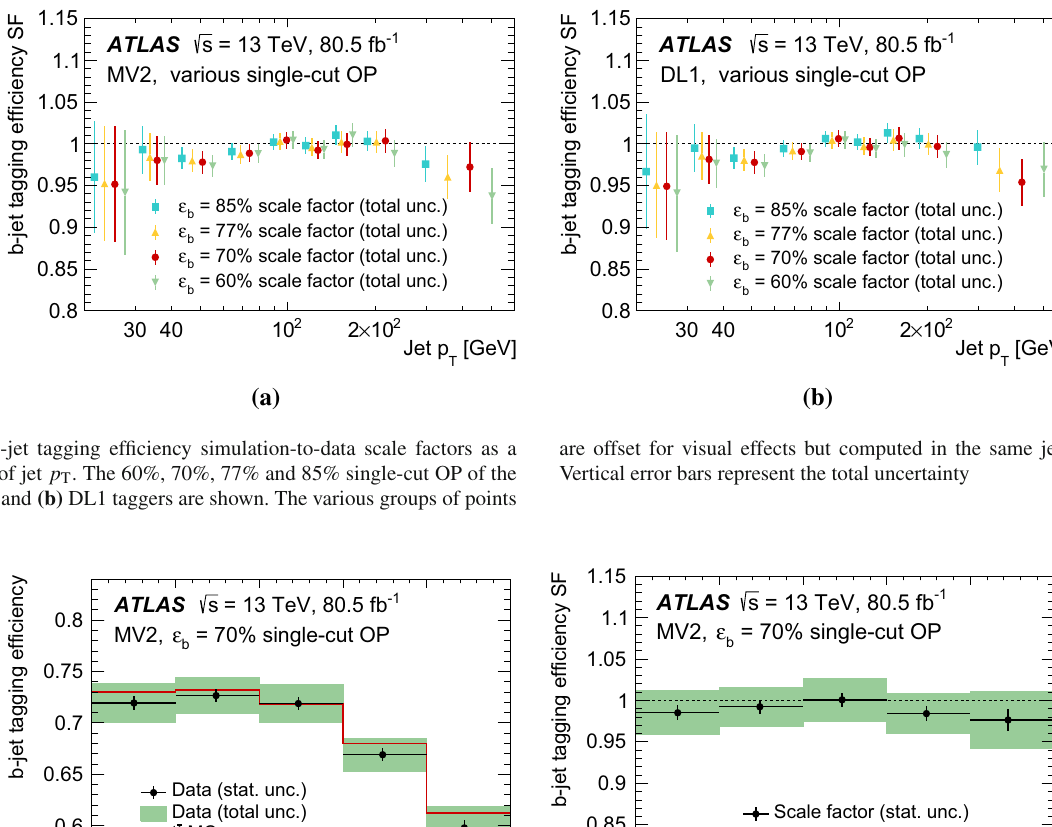
tical uncertainties only while the green bands correspond to the sum in quadrature of statistical and systematic uncertainties. The dots are located at the mean of the b -jet | η | distribution in each | η |